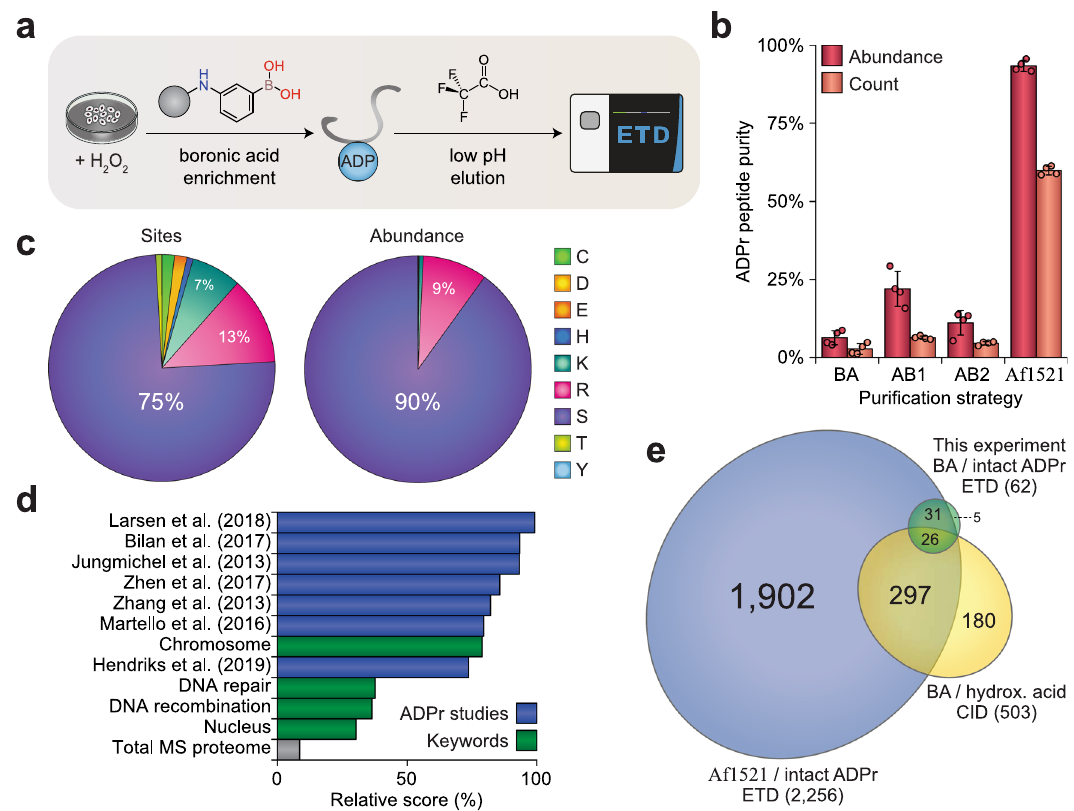
Fig. 3 Integration of boronic acid enrichment with ETD-based MS. a Overview of the experimental design. HeLa cells were cultured in quadruplicate ( n = 4), mock-treated or H 2 O 2 -treated at 1 mM for 10 min, lysed, and trypsinized. ADPr-modi fi ed peptides were enriched using boronate-af fi nity beads, eluted using 0.15% tri fl uoroacetic acid to maintain the intact ADPr moiety, and analyzed using ETD-based high-resolution MS. b Comparison of all ADPr enrichment methods employed in this study, visualizing peptide purity based on either abundance or spectral counting. Data are presented as